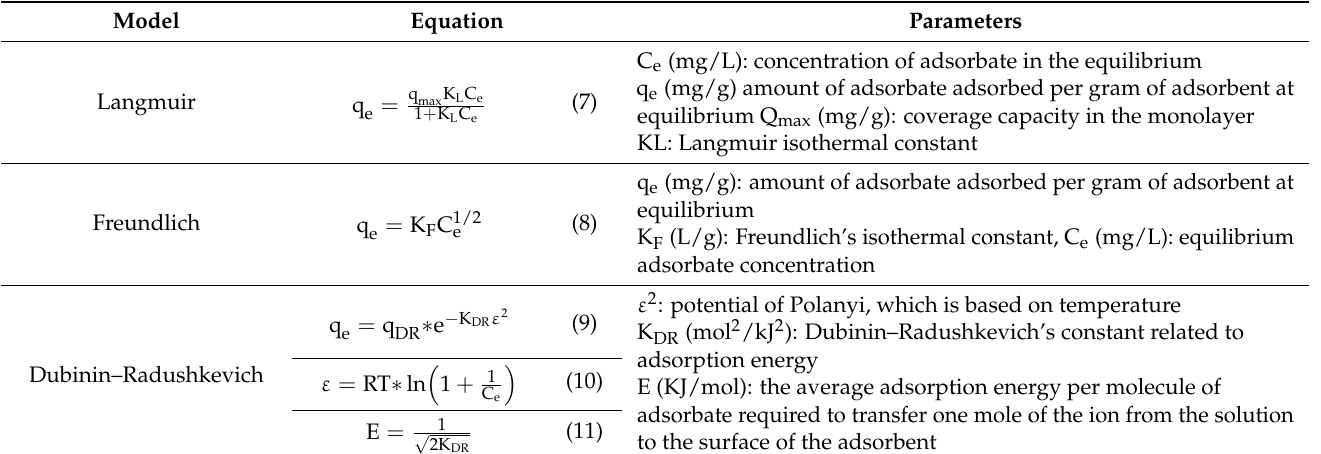
Table 2. Isothermal models [10].